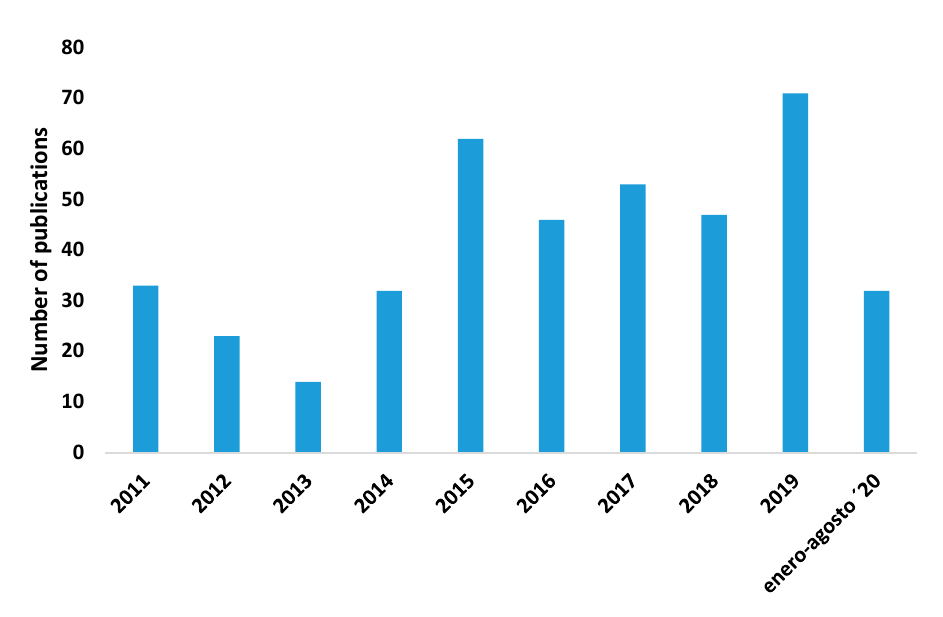
Figure 2. Number of publications per year. Table 1. Description of the 20 most cited publications on sports vision.